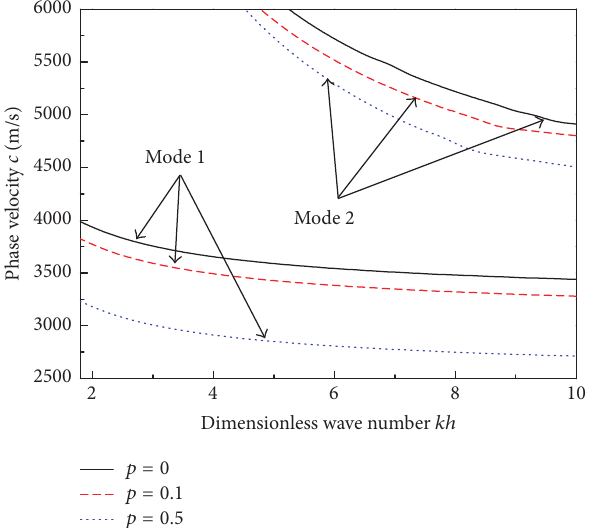
Figure 3: Comparing the dispersion relation of the SH waves with the different gradient parameter 𝑝 for Type B.